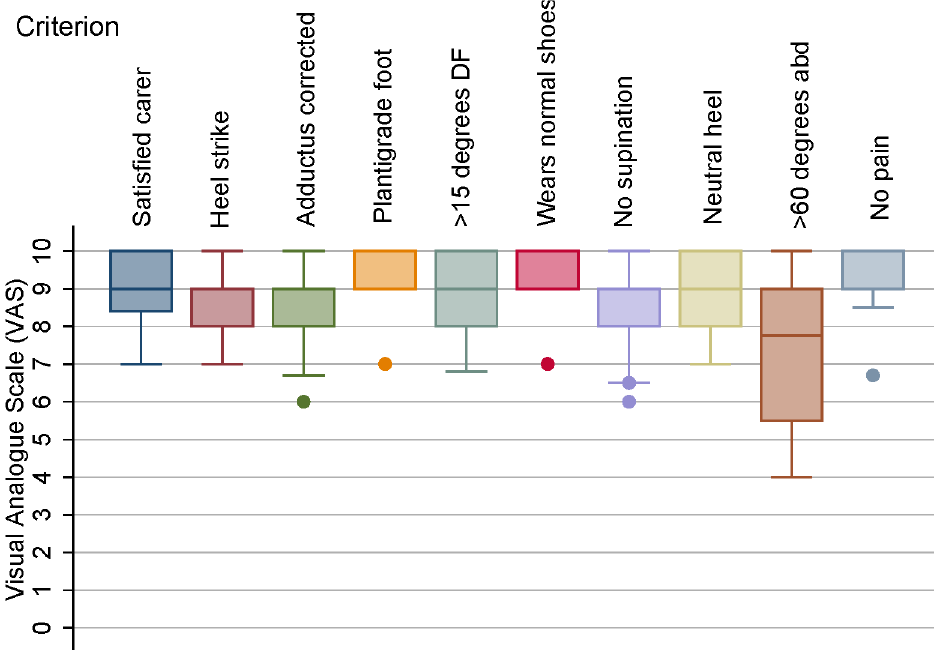
Fig 2. Ratings for successful clubfoot correction after bracing (10 criteria in the order asked on the questionnaire). Box and whisker plot of the final ten criteria. The middle 50% of the VAS ratings are shown as the box. The horizontalline in the box represents the medianvalue. The upper and lower quartilesare indicatedby the whiskers and outliers are indicatedby a circle. (Definitionsof abbreviations: DF = dorsiflexion, abd =